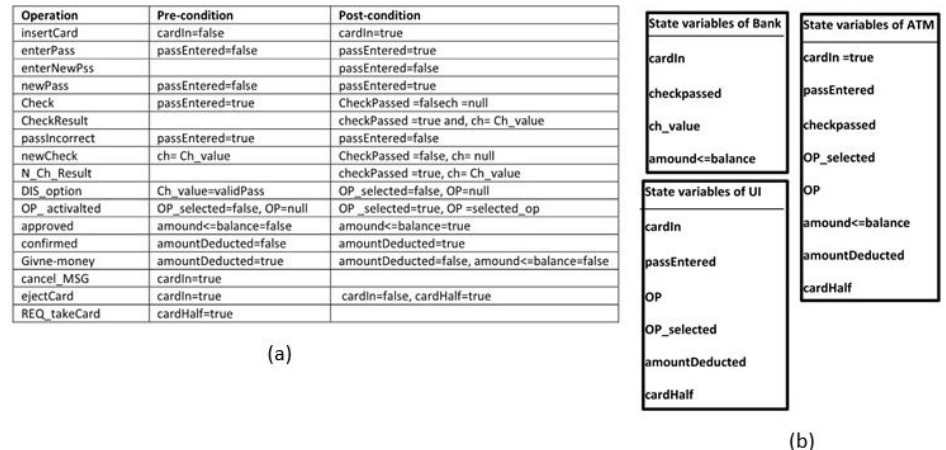
Figure A2. System constraints and state variables that were used for annotation of s-TS scenarios. ( a ) System constraints table of ATM case study. ( b ) State variables of the components of ATM case study.